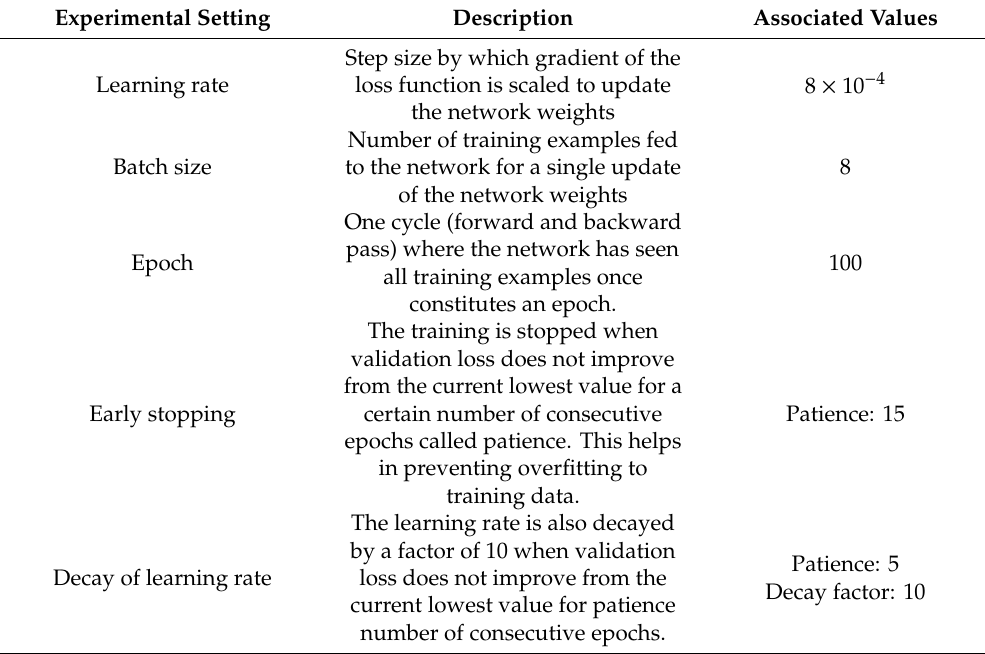
Figure 20. Training and validation loss curves for ( a ) U-net model 1 and ( b ) U-net model 2.